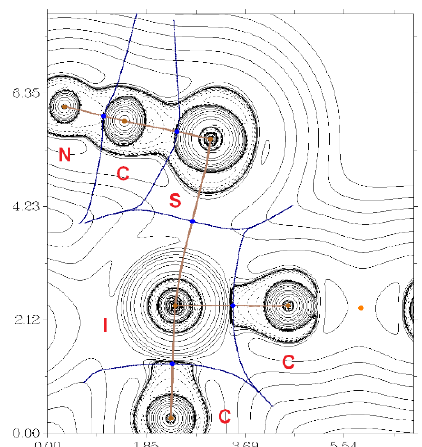
Figure 6. Contour line diagram of the Laplacian of electron density distribution ∇ 2 ρ ( r ), bond paths and selected zero-flux surfaces referring to intermolecular noncovalent interactions I1 ··· N29 in the model heterooctameric cluster {PhI(4-C 6 H 4 OMe)} 4 · {SCN} 4 . Bond critical points are shown in blue, nuclear critical points—in pale brown, length units on X and Y axis are given in Å. Numeration of atoms in the model structure corresponds to their ordering in Table S1, Supporting Information.